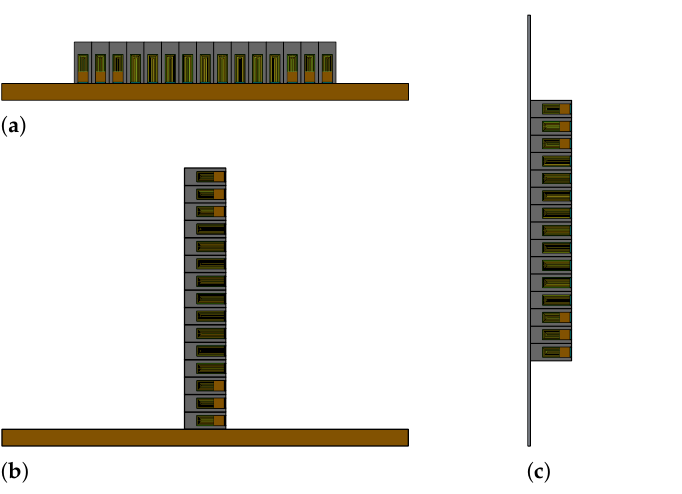
Figure 7. Example layouts: ( a ) horizontal, ( b ) vertical, and ( c ) vertical with vehicle structure. Table 4. Correlations for the horizontal layout.